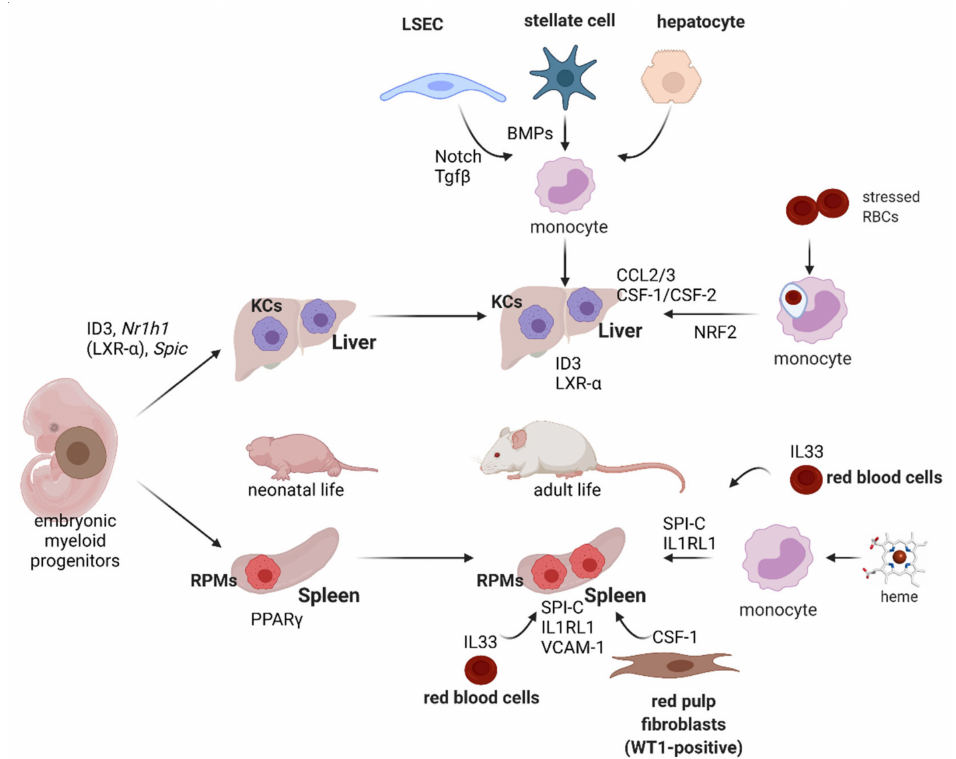
Figure 5. Pathways that imprint KCs’ and RPMs’ identity and enable plasticity of iron-recycling cells. RPMs’ neonatal expansion depends on PPAR γ , whereas in adult life, their identity and numbers are maintained by SPI-C, VCAM-1, the IL33–IL1RL1 axis and CSF1 released by red pulp fibroblasts. Upon hemolytic stress, differentiation of monocytes into RPM-like cells is mediated by Spi-c induction due to heme loading and IL33 signaling. KC development is controlled mainly by ID3 and LXR- α . Differentiation of monocytes into functional KCs in emptied KC niche requires interaction with liver sinusoidal endothelial cells (LSECs), hepatic stellate cells and hepatocytes and soluble factors that are secreted by these cells, including Notch ligands, TGF- β and BMPs. Under erythrolytic stress, blood monocytes were shown to engulf stressed RBCs and differentiate into KC-like cells, which is driven by the chemotactic factors present in the liver and intrinsic NRF2 signaling in